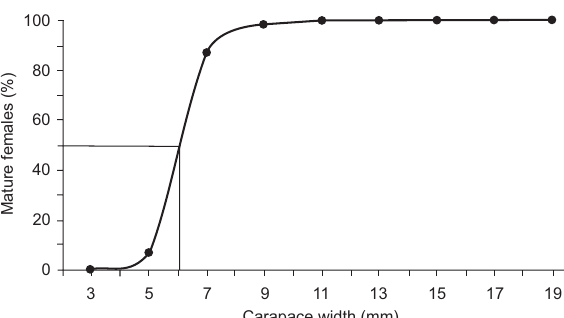
Figure 4. Size at onset of sexual maturity of females (CW rapax from Itaipu Lagoon.